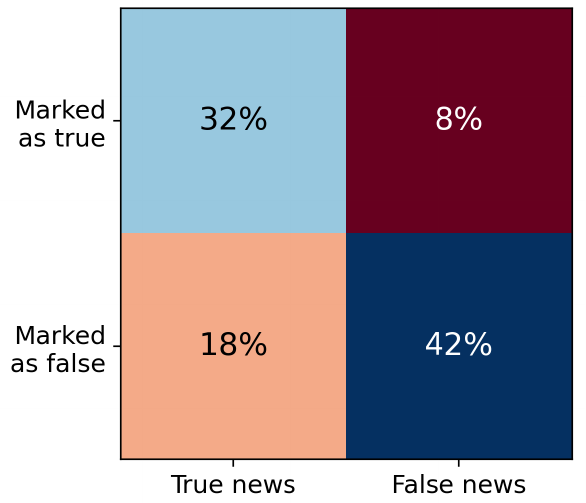
Figure 2. Scores’ distribution regardless of the test settings. Users marked news in agreement with our own classification on average 14.79 times out of 20 questions. The most common score was 15/20.